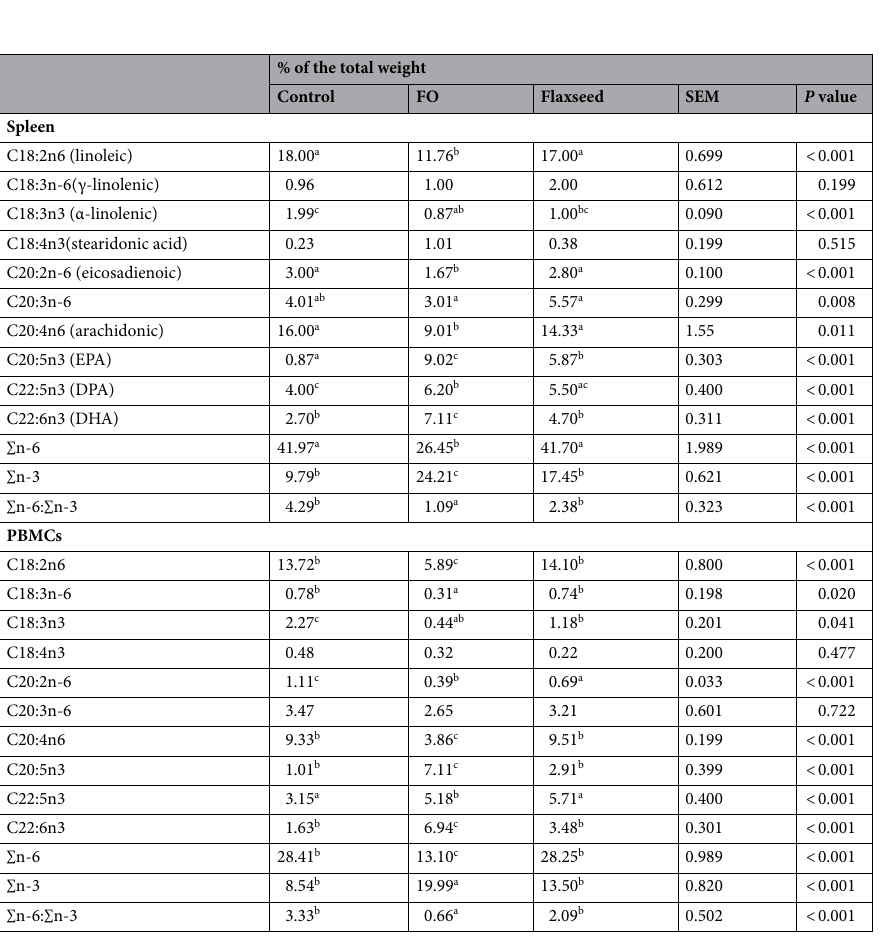
Table 5. Fatty acid composition of spleen and blood leukocytes of 5-wk-old broilers fed the experimental diet. Means within rows with no common superscripts are significantly different (P ≤ 0.05), one-way analysis of variance (ANOVA) and the general linear model procedure of Minitab was applied. Treatment mean differences were identified by Bonferroni tests, values are expressed as means (n = 20, 20 birds per each dietary treatment), pooled standard error of means (SEM), C18:2n6 linoleic, C18:3n-6 γ-linolenic, C18:3n3 α-Linolenic, C18:4n3 stearidonic acid, C20:2n-6 eicosadienoic, C20:4n6 arachidonic, C20:5n3 eicosapentaenoic acid